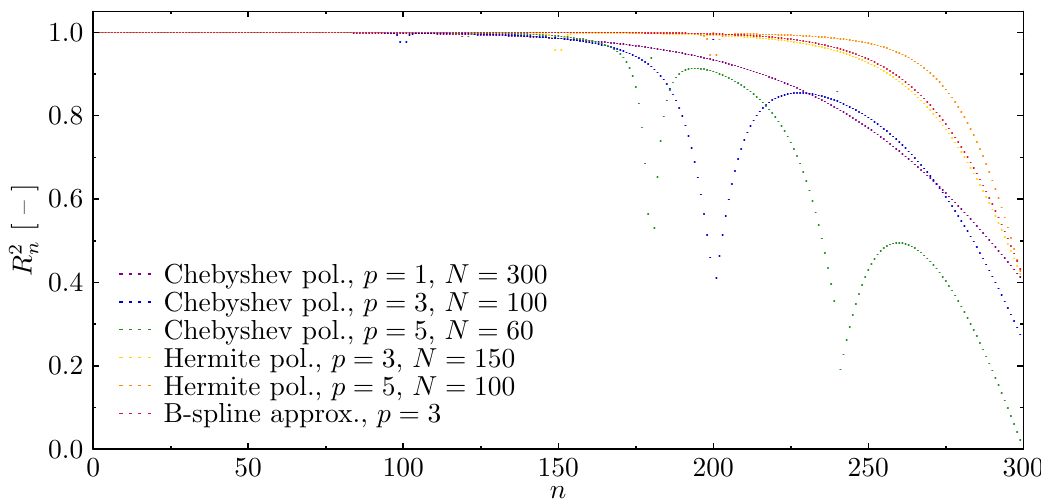
Figure 6. Fitness of natural vibration modes of the rod calculated based on different approximation polynomials, in the case of the rof with fixed